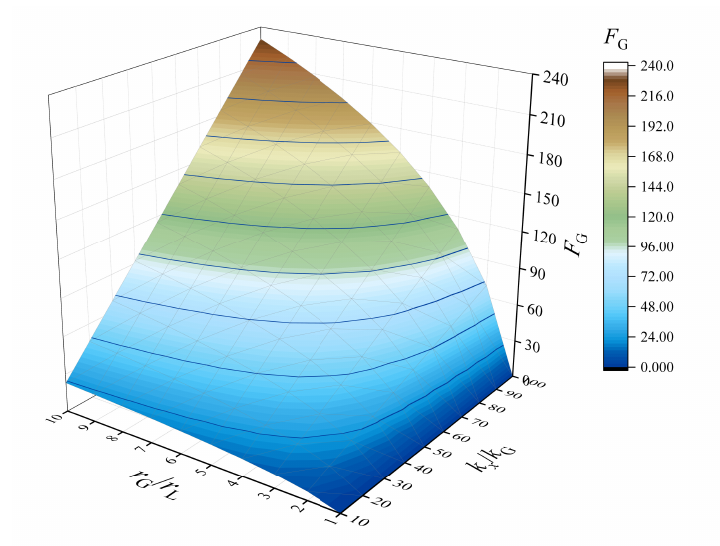
Figure 11. Grouting influence factors under different grouting ring